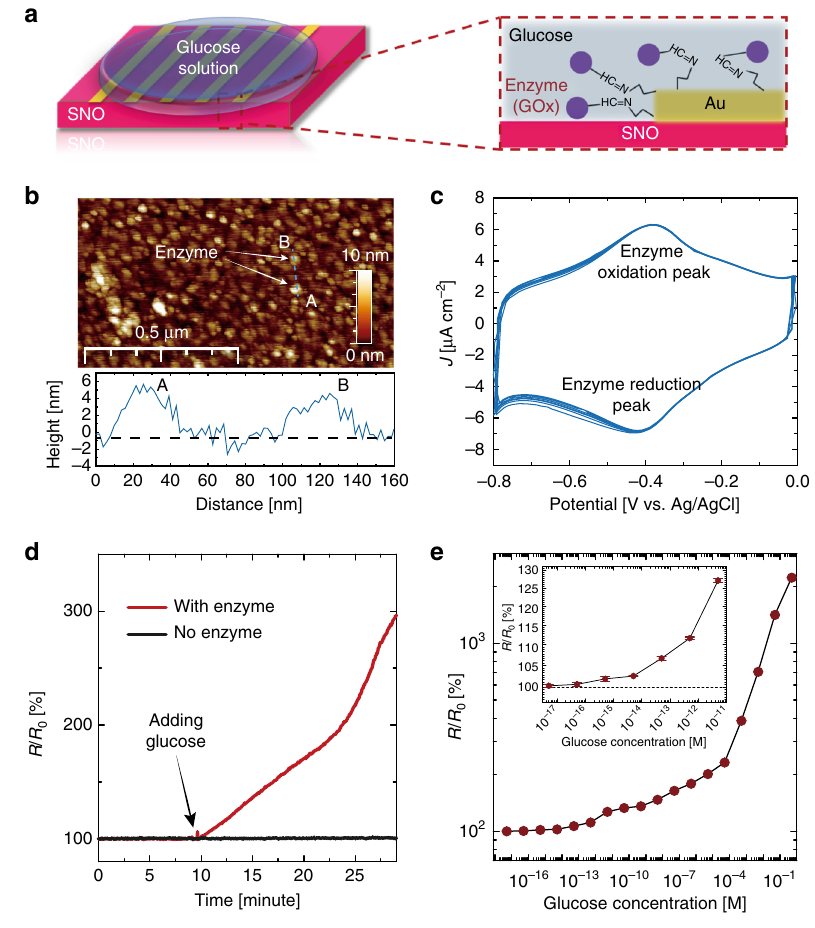
Fig. 2 Electrical response of nickelate devices interfaced with glucose without external energy. a Schematic fi gure of the enzyme-SmNiO 3 (SNO) device, with glucose oxidase (GOx) decorated Au electrodes. Before the reaction, glucose solution was added on top of the device surface, as shown in the zoomed in fi gure on the right. b The surface morphology of GOx-modi fi ed Au surface measured by atomic force microscopy (AFM). The GOx molecules are the bright dots on the surface and a line scan along AB shows the height of the GOx is around 4 – 5 nm. c Cyclic voltammetry (CV) measurements with the GOx-modi fi ed Au surface as a working electrode. Electrochemical reduction and oxidation peaks of GOx were observed as expected 14 . d Temporal resistance of the enzyme – SNO device after 0.5 M glucose solution is applied as shown in ( a ). A clear increase in resistance is observed after the glucose solution is applied (red curve). No change in resistance was observed for the control SNO sample without any GOx modi fi cation (black curve in the inset). R 0 is the resistance of the pristine enzyme – SNO device. e Resistance increase of the enzyme – SNO device after the device is soaked in glucose solution for 1 h with different concentration. A monotonic increase of R / R 0 is observed with increasing glucose concentration. The enzyme – SNO device is responsive to glucose concentration down to 5 × 10 − 16 M (signal to noise ratio >3). The error bar shown in inset plot was determined from the standard deviation